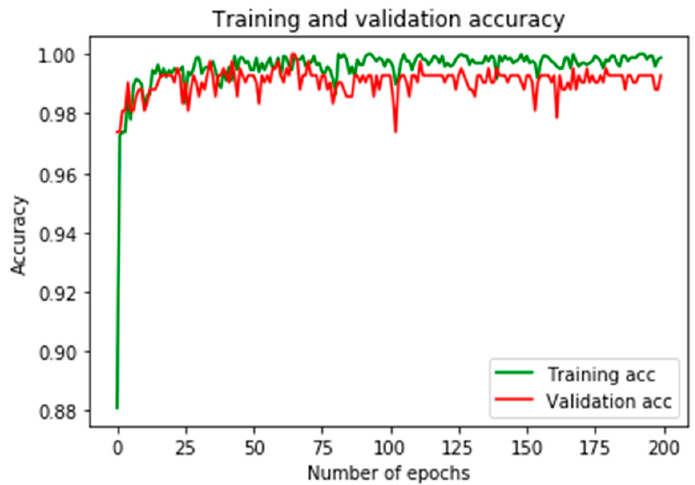
Figure 11. Showing training and validation losses using ResNet101.